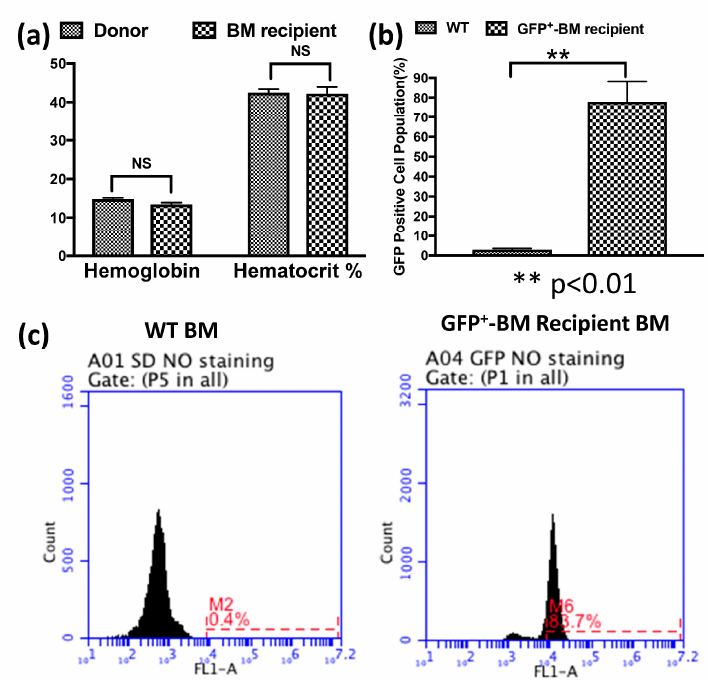
Figure 2. Transplanted bone marrow (BM) cells repopulated the blood cells of irradiated recipient rats. ( a ) There is no significant difference in hemoglobin or hematocrit between donor and chimeric rats receiving BM transplantation. ( b ) Around 80% of BM cells in the rats that received GFP + BM and underwent RI are GFP positive. ( c ) shows the flow cytometry analysis of the bone marrow from WT SD rats and the chimeric SD rats that received GFP + BM.